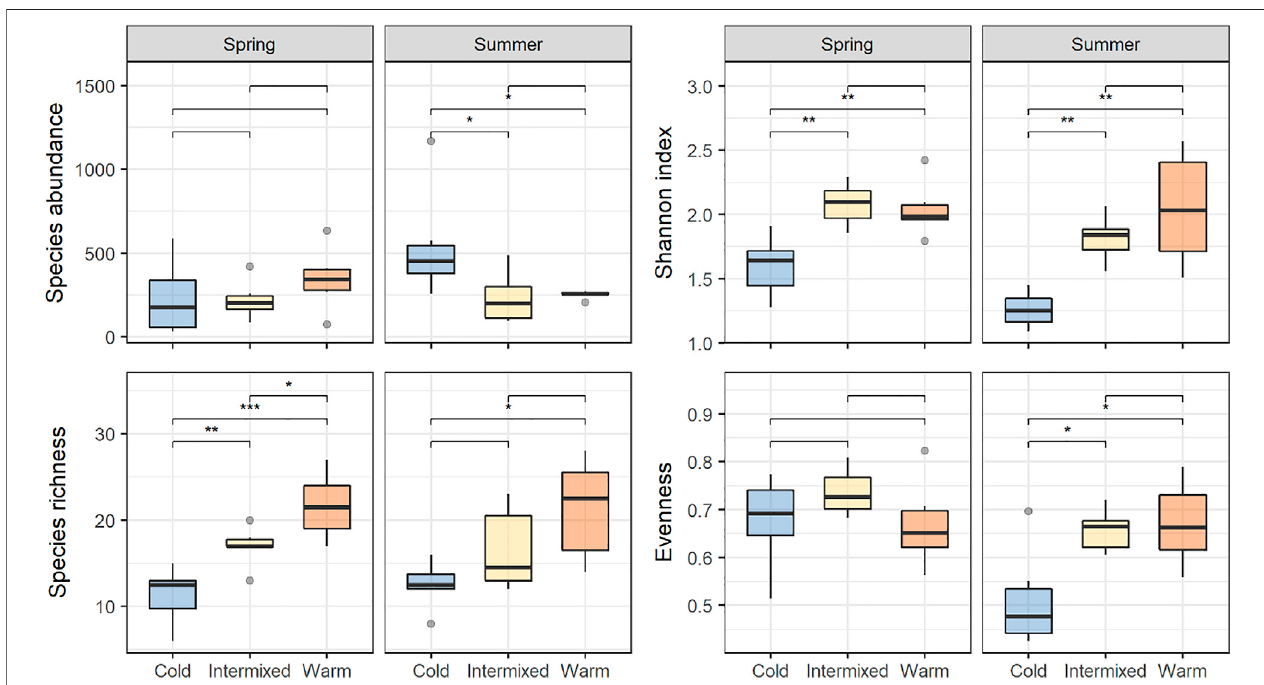
FIGURE 4 | Species abundance and -richness, Shannon index and Evenness for each of the thermal regions, and their comparison between seasons. Asterisks indicate signi fi cantdifferences between treatments detected with Wilcoxson signed-ranks post hoc test as indicated by the bracket,* = p < 0.05, ** = p < 0.01, *** = p <